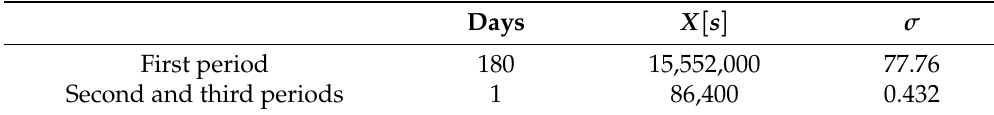
Table 1. Simulation parameters used in window length calculations.